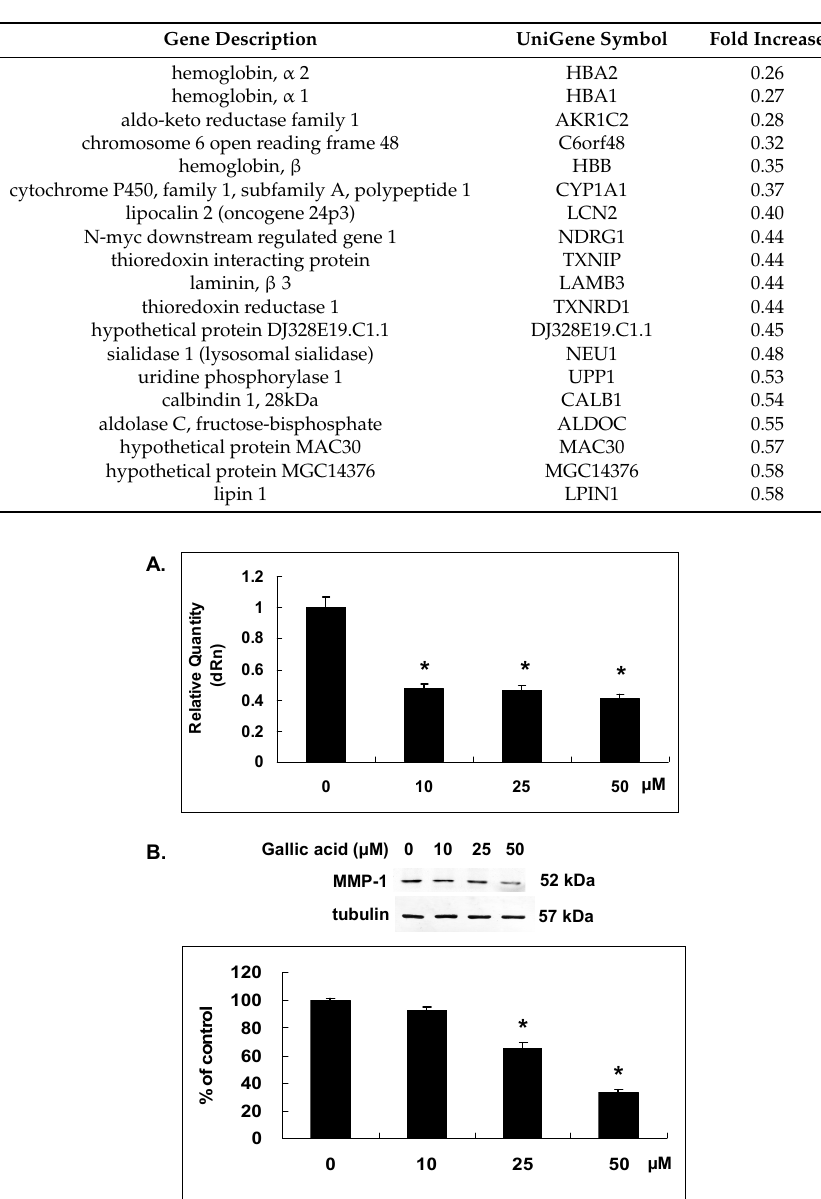
Table 2. List of genes upregulated by gallic acid in nasopharyngeal carcinoma.